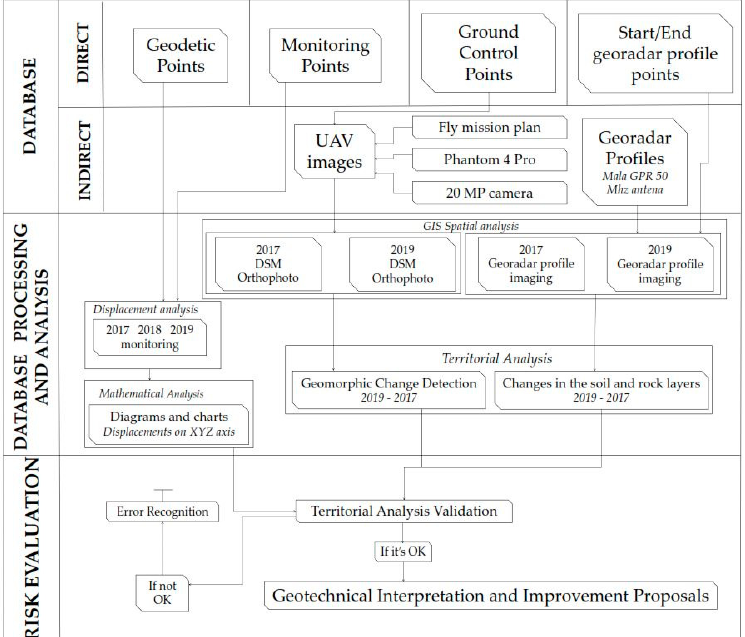
Figure 6. Methodological flowchart.